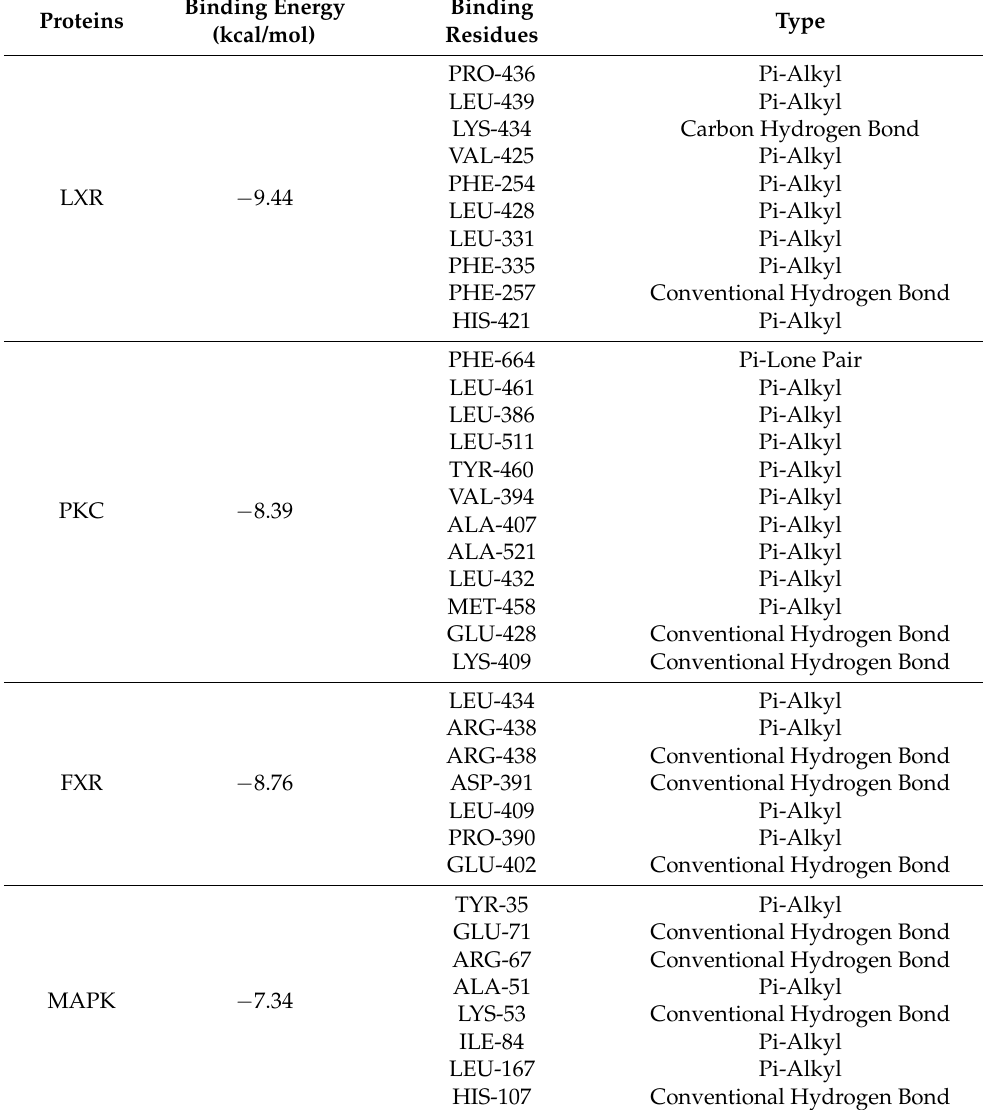
Table 3. Intermolecular interactions between obeticholic acid and LXR, PKC, FXR, and MAPK.